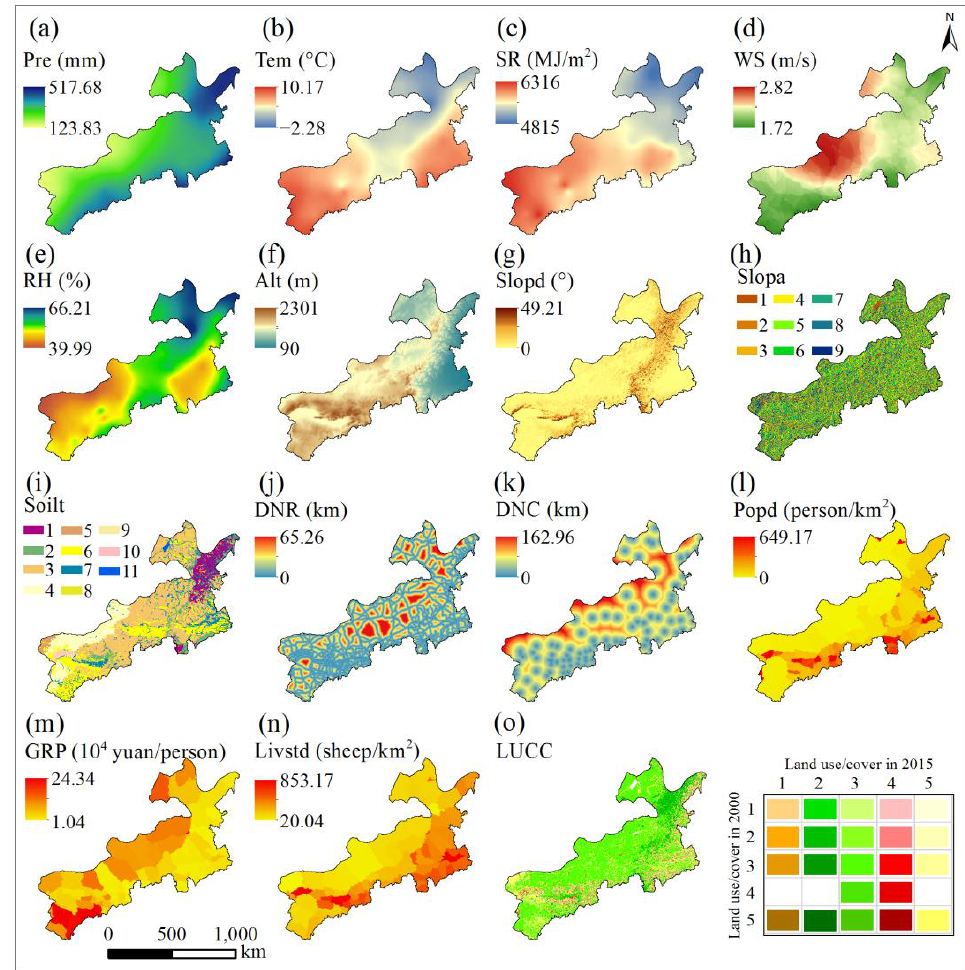
Figure 4. The spatial distributions of all factors. The numbers in the legend of ( h ) represent (1) Flat ground, (2) North slope, (3) Northeast slope, (4) East slope, (5) Southeast slope, (6) South slope, (7) Southwest slope, (8) West slope, and (9) Northwest slope. The numbers in the legend of ( i ) represent (1) Luvisols, (2) Semi-luvisols, (3) Caliche soils, (4) Arid soils, (5) Desert soils, (6) Skeletol primitive soils, (7) Semi-hydromorphic soils, (8) Hydromorphic soils, (9) Saline soils, (10) Anthrosols, and (11) Others. The numbers in the legend of ( o ) represent (1) Cropland, (2) Forest, (3) Grassland, (4) Construction land, and (5) Unused land. Pre: precipitation; Tem: air temperature; SR: solar radiation; WS: wind speed; RH: relative air humidity; Alt: altitude; Slopd: terrain slope; Slopa: slope aspect; Soilt: soil type; DNR: distance to the nearest road; DNC: distance to the nearest county centers; Popd: population density; GRP: Per capita gross regional product; Livstd: livestock density; LUCC: land use/cover change.